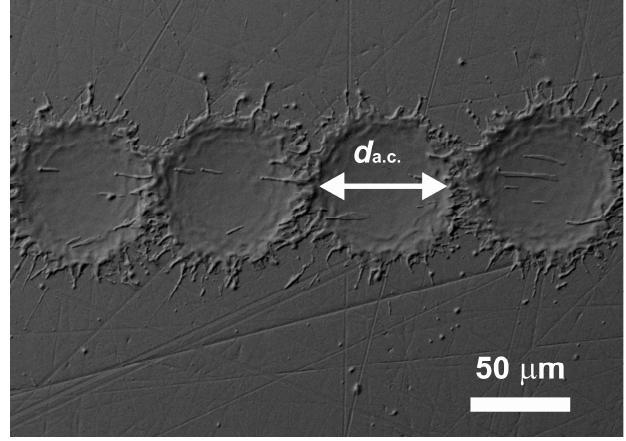
Figure 1. SEM image of ablation craters formed due to a single action of a laser pulse on the X16CrNi25-20 steel surface. Laser pulse parameters: a wavelength of 1064 nm, a duration of 120 ns, a frequency of 110 kHz, and a pulse energy of 0.43 mJ.